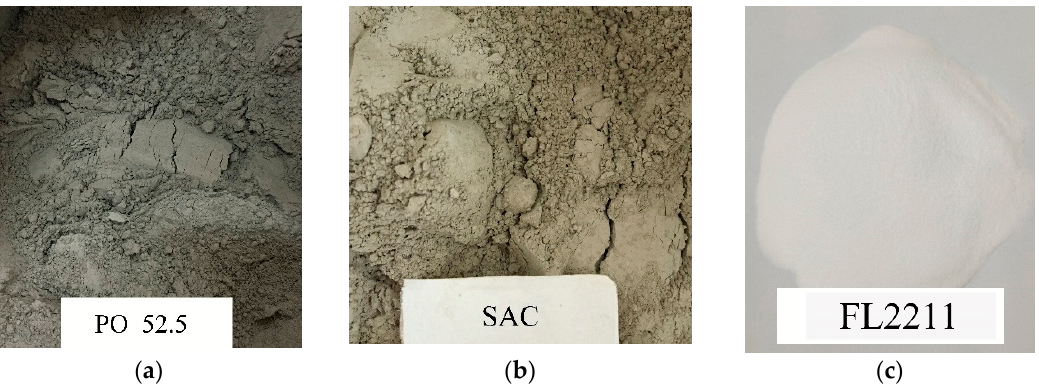
Figure1. Materialsofself-levelingmortar(SLM):( a )ordinaryPortlandcement(OPC);( b )sulfoaluminate Figure 1. Materials of self-leveling mortar (SLM): ( a ) ordinary Portland cement (OPC); ( b ) cement (SAC); ( c ) redispersible powder sulfoaluminate cement (SAC); ( c ) redispersible powder (RP).